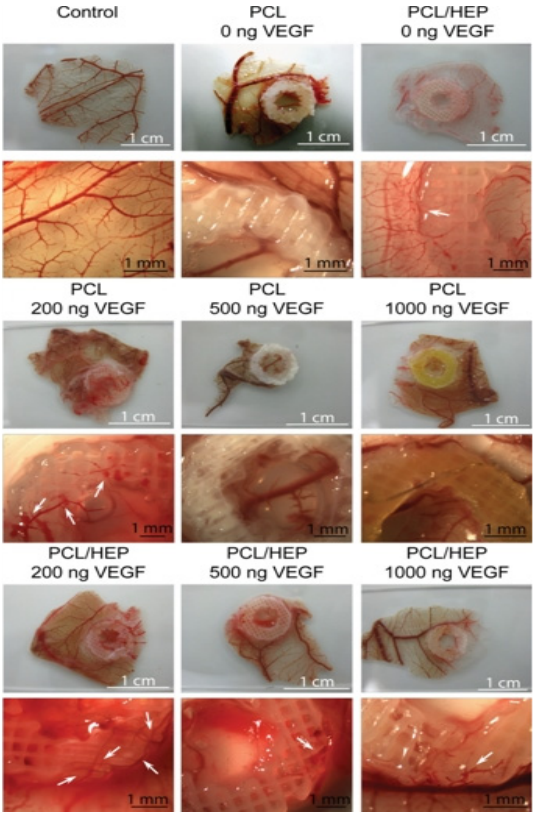
Figure 7. CAM assays were performed on PCL and heparin-coated 3D-printed PCL scaffolds with three different concentrations of VEGF. The 200 ng loading of VEGF induced stent formation with normal morphological vessels. Reprinted with permission from Ref. [86], Copyright 2016, Elsevier.